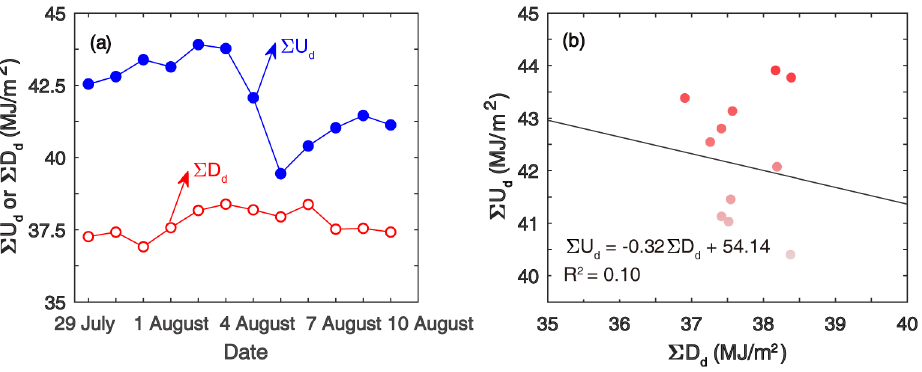
Figure 4. D d and Σ U d . ( a ) Daily cumulative long-wave radiation, ( b ) Σ D d does not correlate with Σ U d .